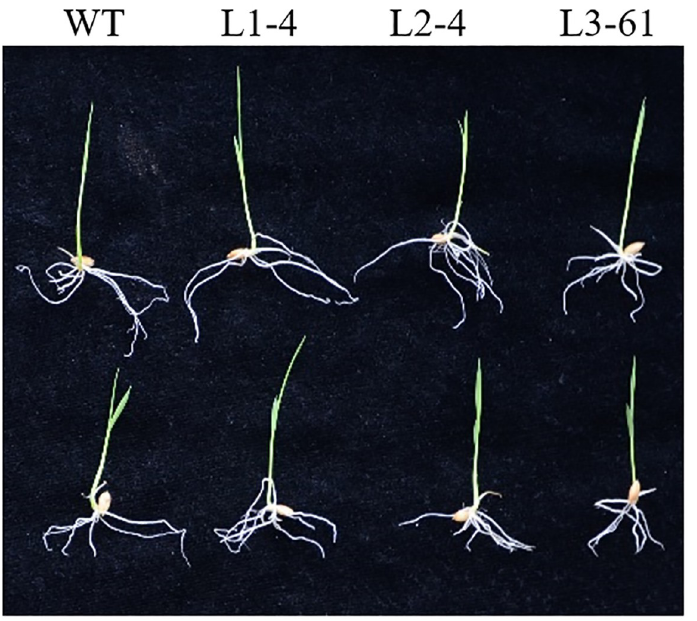
Fig 5. Phenotype of wild type, MYC2-like overexpression (L1), MYC2-like overexpression in cyp2 -RNAi (L2) and cyp2 -RNAi (L3) under salt